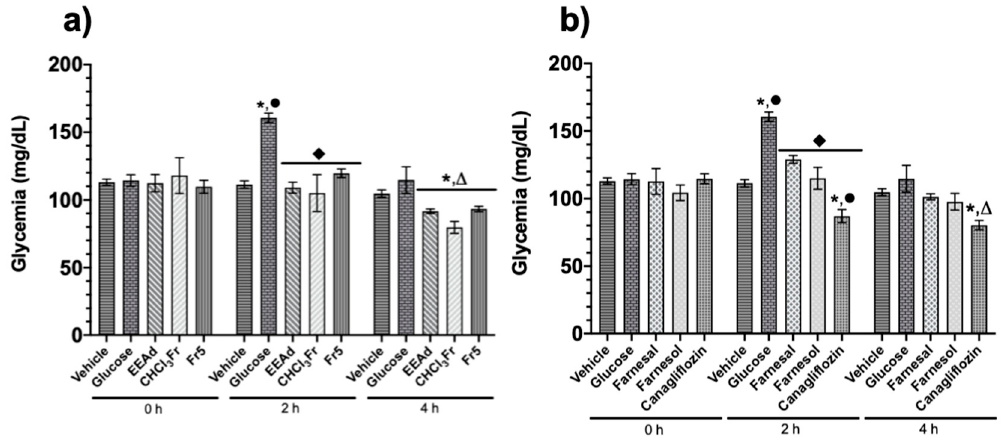
Figure 3. Effect of products isolated from A. diversifolia and canagliflozin on the oral glucose tolerance test (OGTT). ( a ) Groups treated with vehicle, glucose (1.5 g / kg), EEAd, CHCl 3 Fr (200 mg / kg), and Fr5 (50 mg / kg). ( b ) Groups treated with vehicle, glucose (1.5 g / kg), farnesal, farnesol, and canagliflozin (50 mg / kg). Data are expressed as means ± SEM, n = 6; * p < 0.05 vs. initial values; • p < 0.05 vs. vehicle for 2 h; ♦ p < 0.05 vs. glucose for 4 h; Δ p < 0.05 vs. vehicle for 4 h.